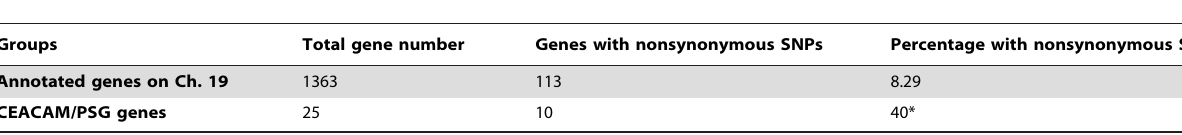
Table 2. A large fraction of human CEACAM/PSG genes contain nonsynonymous SNPs.